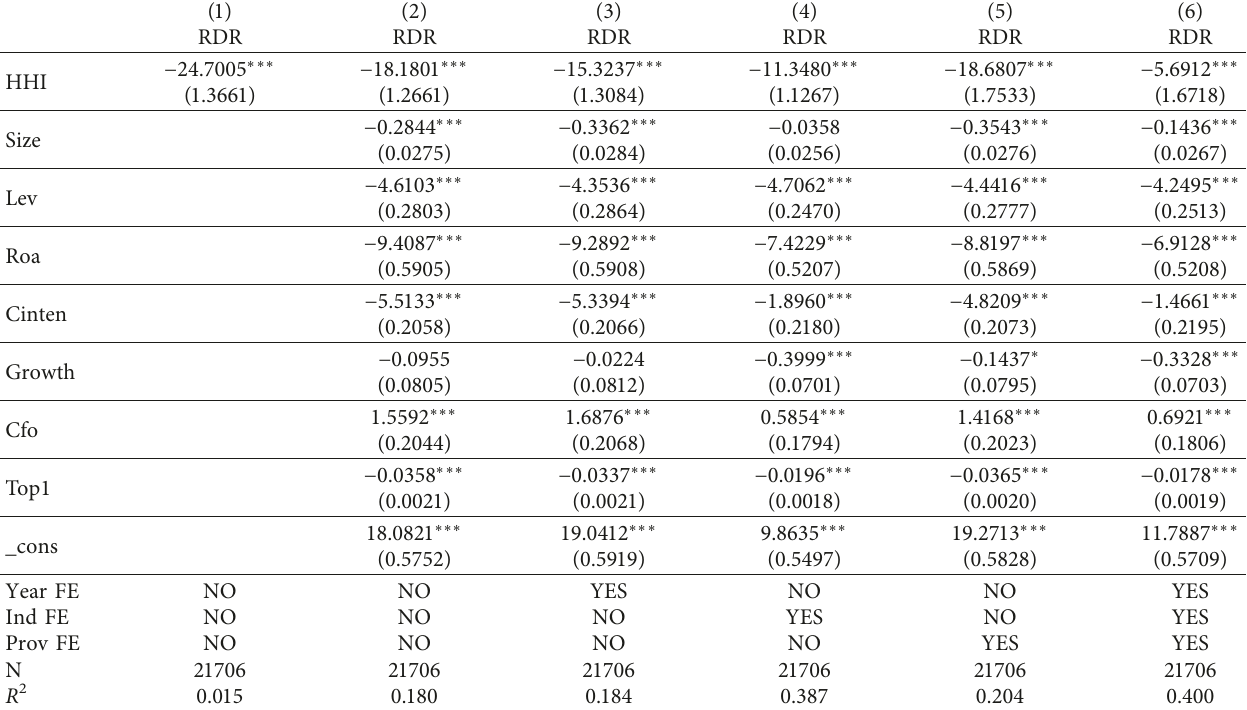
Table 3: Baseline regression